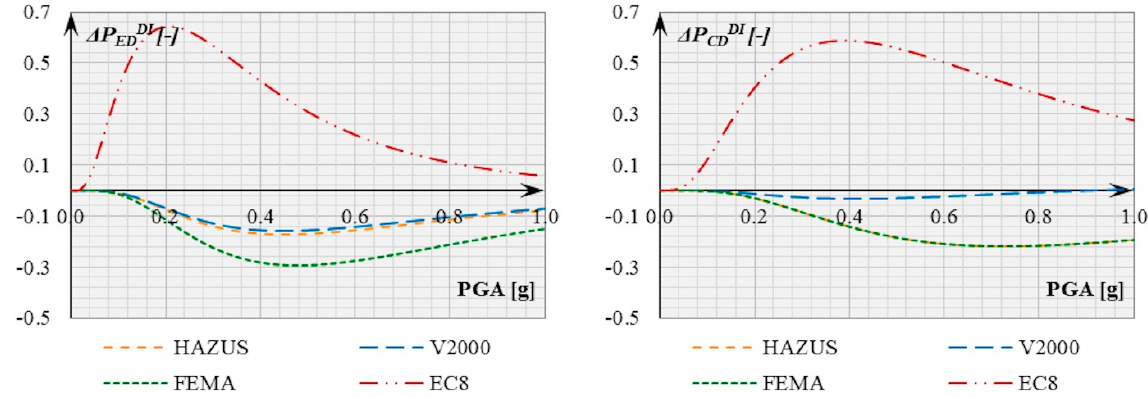
Figure 26. Differences between fragility curves calculated using other methods and the ones calculated using the modified DI method, for the damage states ED ( left ) and CD ( right ).